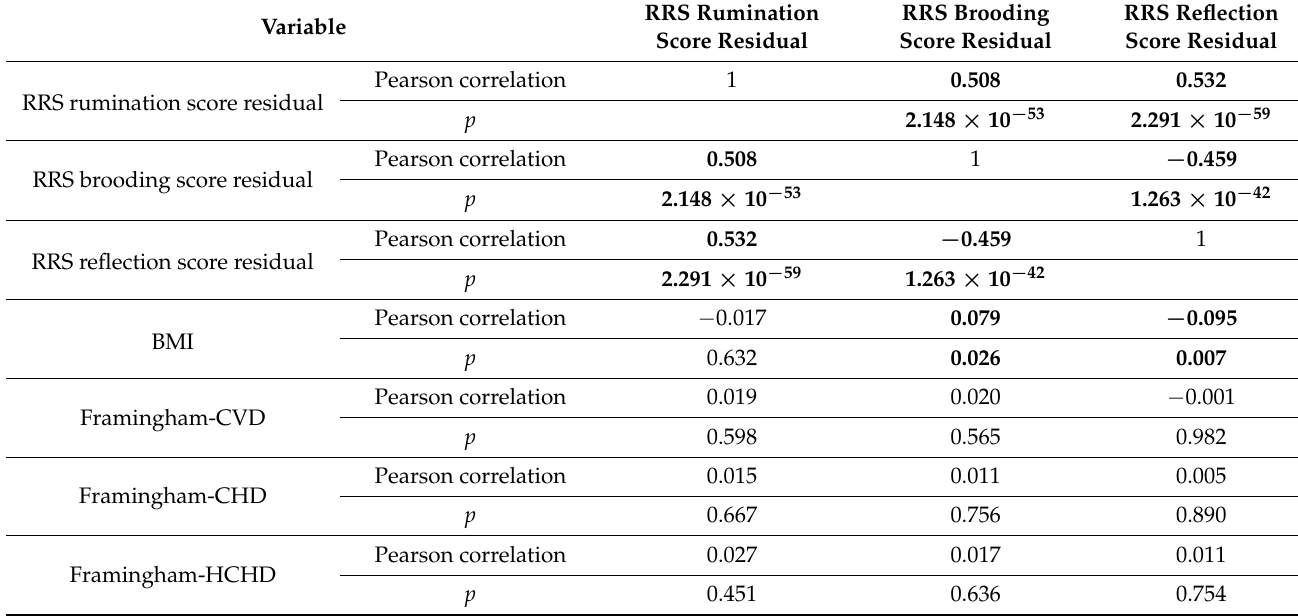
Table 2. Pearson correlations of RRS score residuals with cardiovascular and psychiatric risk scores ( n = 795). Significant ( p ≤ 0.05) correlations are marked in bold. Among the cardiovascular risk scores, only BMI is correlated, and only weakly, with RRS scores: positively with brooding and negatively with reflection. RRS rumination and brooding are correlated moderately with all ten BSI scores, but reflection has a weak correlation with obsessive-compulsive and depressive